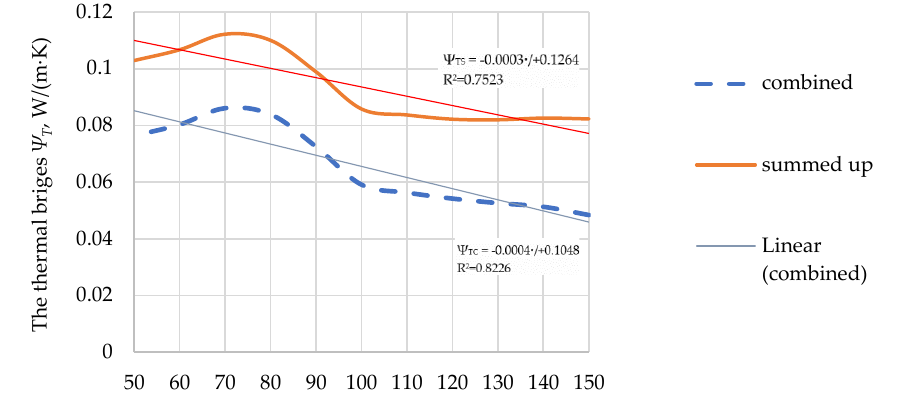
Figure 13. Dependence of the Ψ T value of the thermal bridge on the distance of the window installation from the load-bearing layer edge and calculation method.